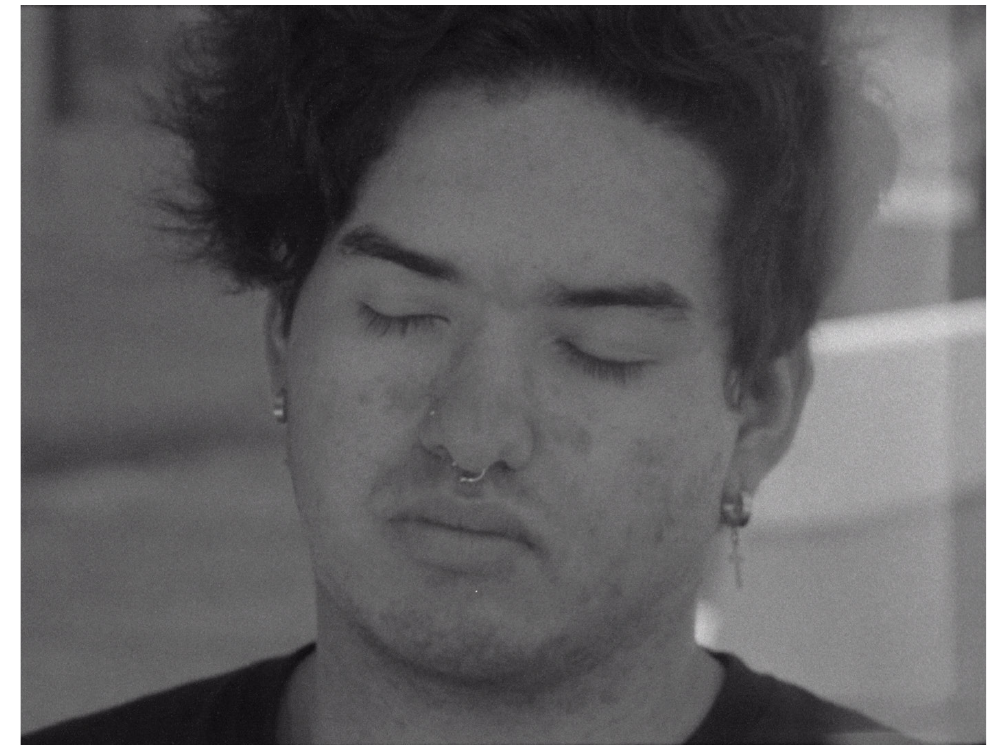
Figs. 6 – Still from 13 Ways of Looking at a Blackbird (2021). Courtesy of the